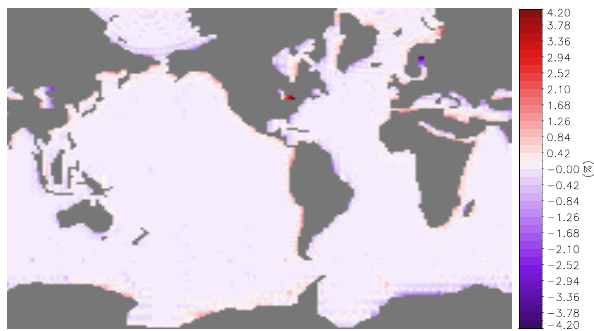
Fig. 8. Relative error obtained (in %) with the bilinear regridding from the LMDz grid to the ORCA2 grid when each component is partitioned over 3processes and when the global search is not acti-